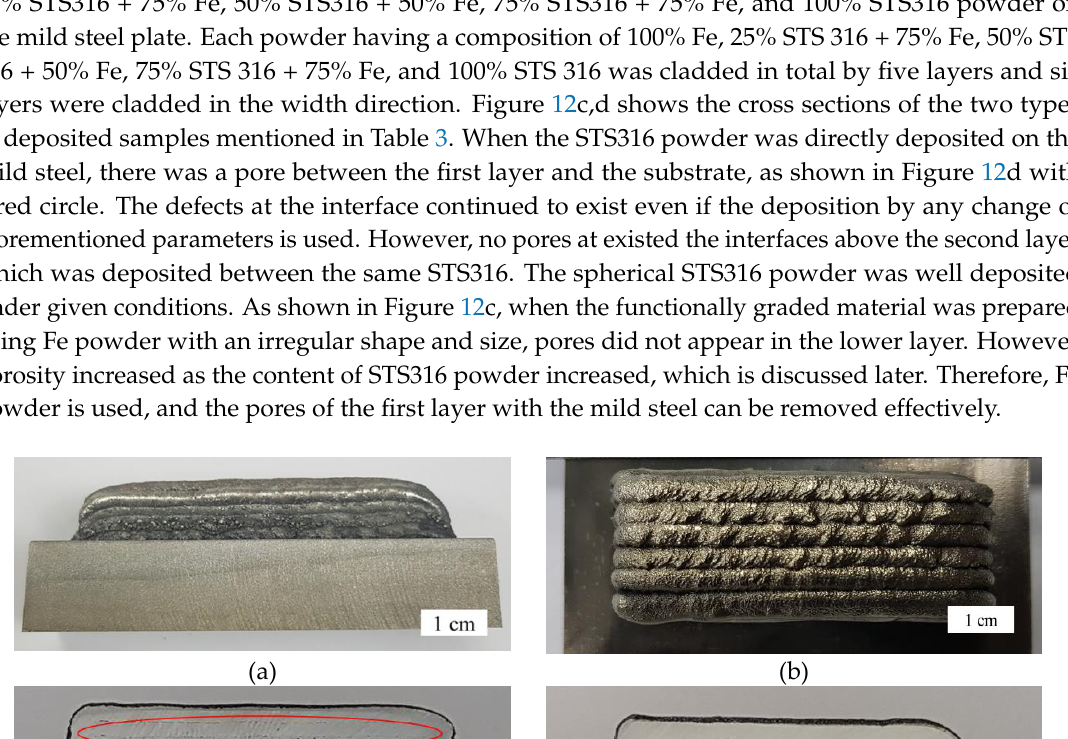
(b) Figure 13. Microstructure of interface between ( a ) sample 1 and ( b ) sample 2.